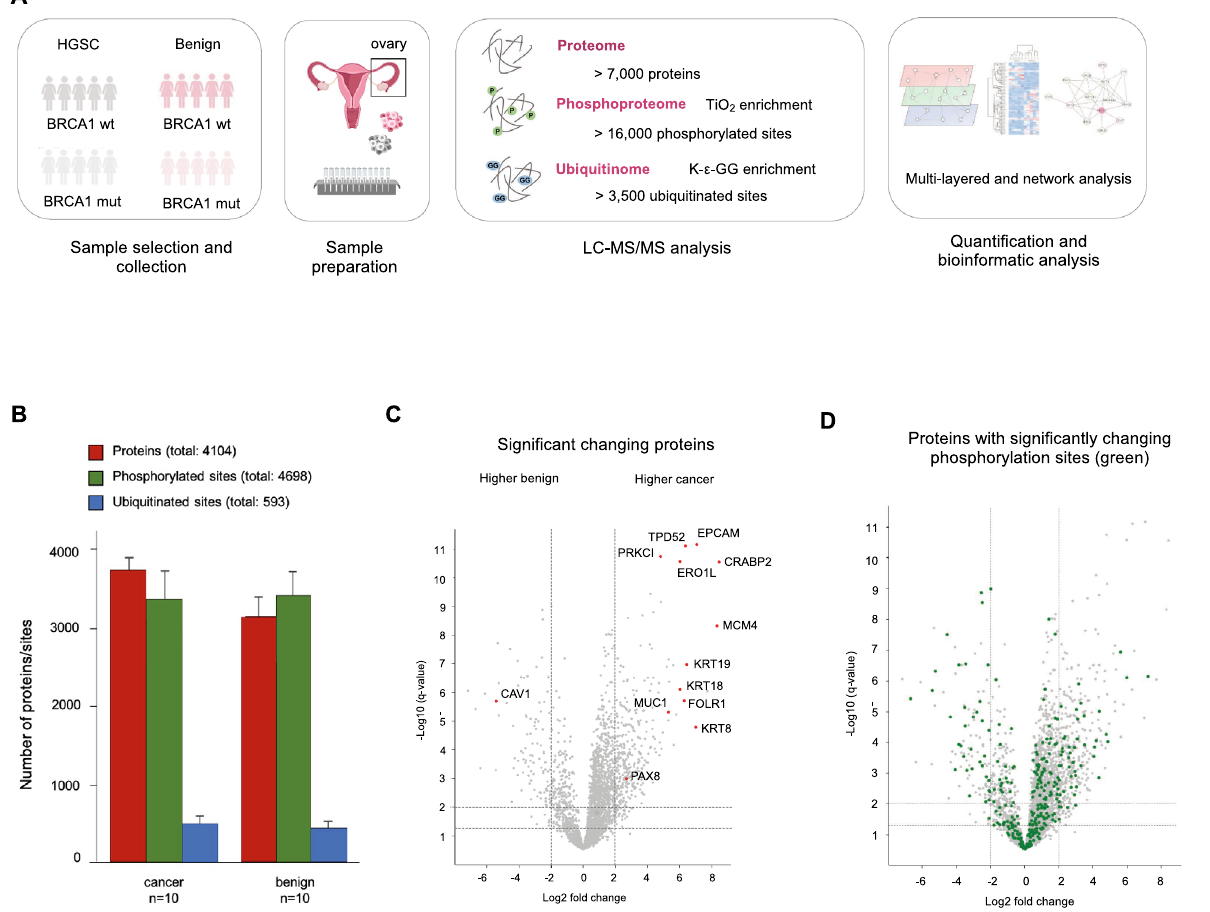
Figure 1. Proteome and phosphoproteome analysis shows differentially regulated signaling processes in ovarian cancer and benign tissues. (A) Workflow of the sample preparation and multi-layered proteomic analysis of high-grade serous cancer (HGSC) and benign epithelial ovarian tissues. (B) Number of quantified proteins (red), phosphorylated sites, probability score > 0.75 (green) and ubiquitinated sites, probability score > 0.75 (blue) in high-grade serous cancer (HGSC) and benign tissues. Data are presented as mean ± SD. (C) Volcano plot of the pairwise comparison between HGSC and benign ovarian tissue proteomes. Marked in red are proteins reported in the literature as being altered in HGSC or epithelial ovarian cancer 15,94–97 . Dotted lines indicate q-value < 0.01 and < 0.05 and log2 fold change > 2 thresholds. Positive and negative log2 fold changes indicate enrichment in cancer and benign tissues, respectively. (D) Proteins as in Figure A (grey) with significant phosphorylation sites (green), showing the decoupling between regulated phosphorylated sites and their corresponding protein. Values expressed as log2 fold change of protein